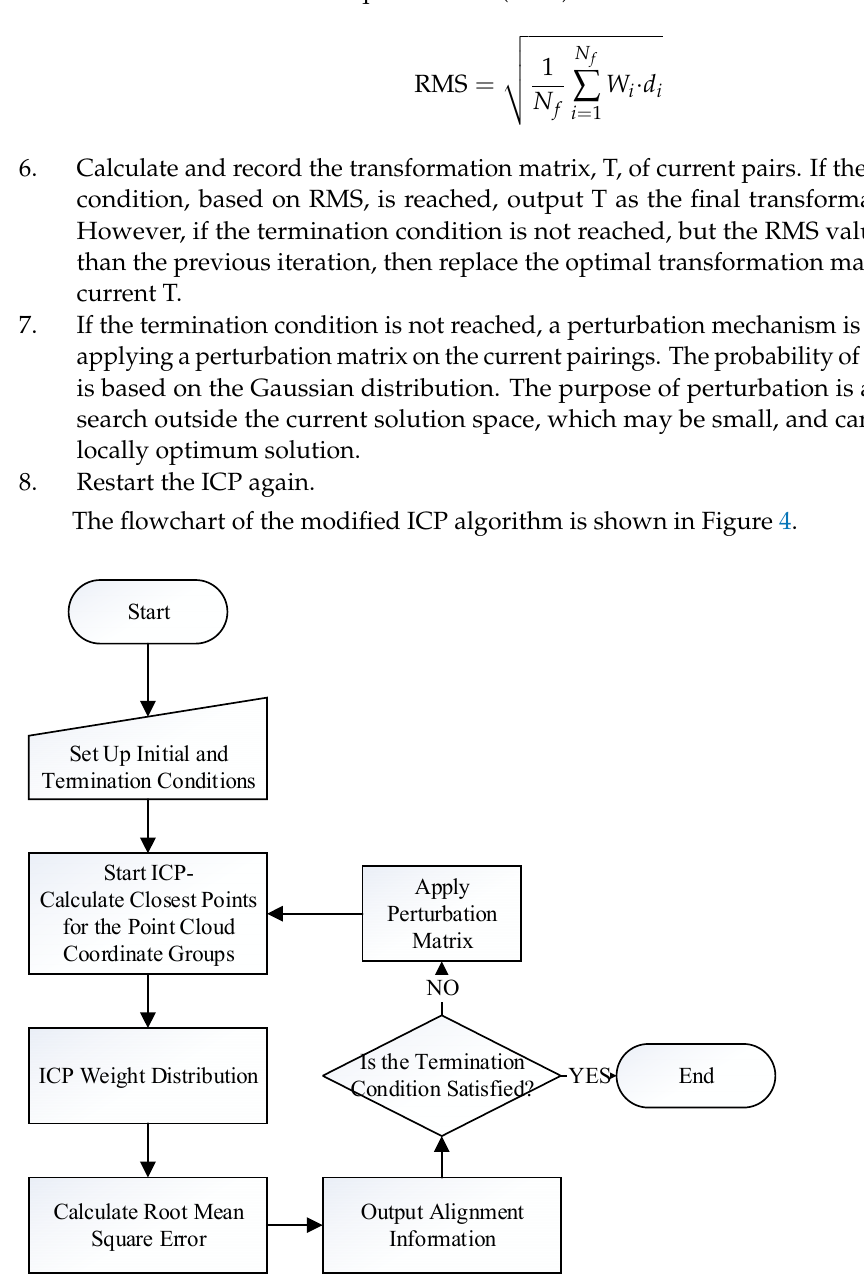
Figure 4. Flowchart of the modified ICP algorithm used in this investigation.